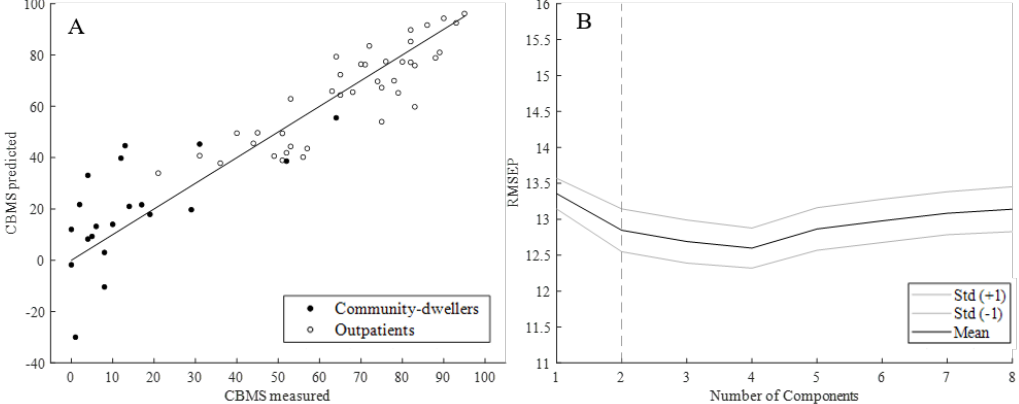
Figure 6. ( A ) Predicted vs. measured CBMS total score from standard clinical tests for outpatients and community-dwellers; ( B ) mean RMSEP +/− one standard deviation across eight components.